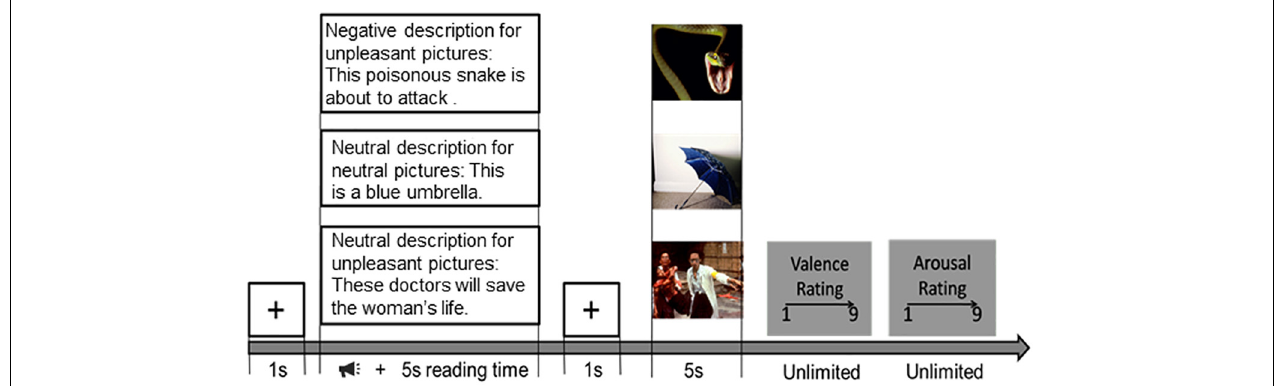
FIGURE 1 | Emotion regulation task procedure. Then each picture would be preceded by a description of the upcoming picture. When the sound ended, the subject would read the description and have more than 5 s to read it for the subject to understand its meaning. After the reading, a black fixation cross appears on a black screen for 1 s. During the presentation of the stimuli, participants were asked to understand the picture based on the preceding textual description. After each picture was presented, participants were required to give their rating scores (1 = negative, 9 = positive) and arousal (1 = calm, 9 = aroused) of each